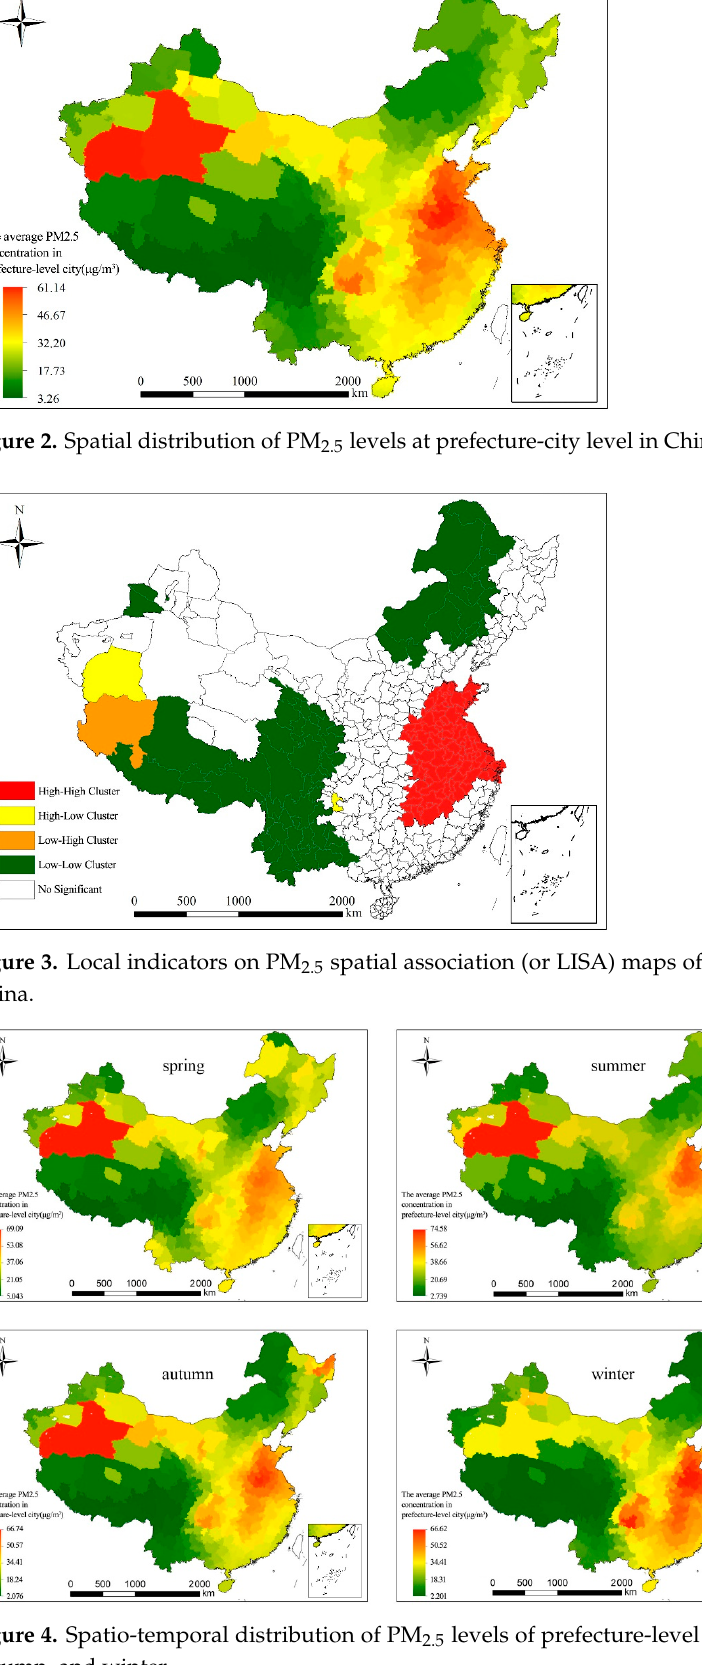
Figure 4. Spatio-temporal distribution of PM 2.5 levels of prefecture-level cities in spring, summer, autumn, and winter.